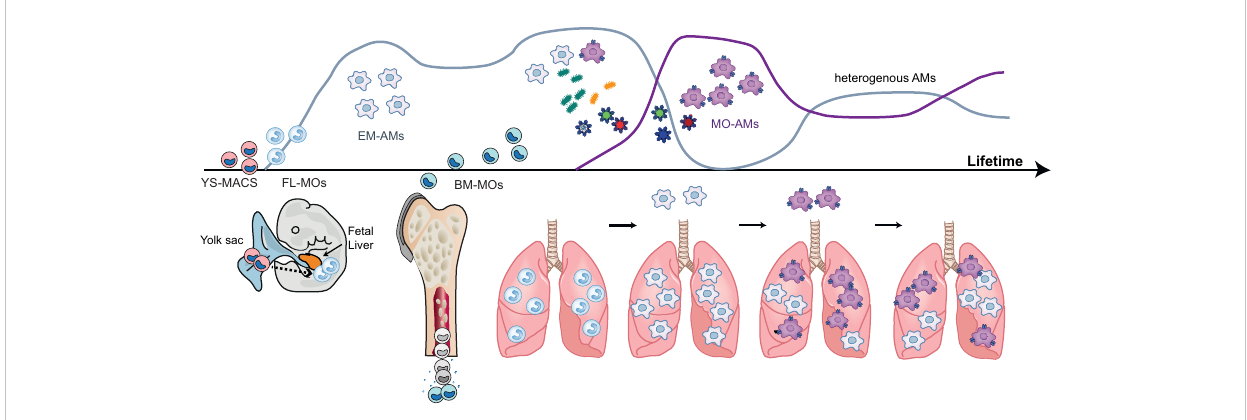
FIGURE 2 Ontogeny and development of alveolar macrophages during life. During the pre- and post-natal period, alveolar macrophages (AMS) have an embryonic ontogeny as they derive from successive waves of precursors originating fi rst from the yolk sac (YS-MACS) and then from the fetal liver (FL-MOs). These AMs of embryonic origin display a high proliferative capacity which allows them to occupy the expanding alveolar niche compartment and to self-sustain with little or no contribution from bone marrow-derived monocytes (BM-MOs) However, during life and the ageing process, BM-MOs will gradually in fi ltrate the lung, differentiate into AMs and progressively contribute to the AM population. The contribution of BM- MO to the pool of AMS increases following episodes of in fl ammation and/or respiratory infections inducing the depletion of the alveolar niche and the recruitment of MOs into the alveoli. The magnitude, persistence and functional consequences of this BM-MO contribution to the AM pool are context-dependent and the mechanisms dictating this heterogeneity are not fully elucidated. Figure adapted from Karen De Vlaminck PhD thesis (Bioengineering Sciences